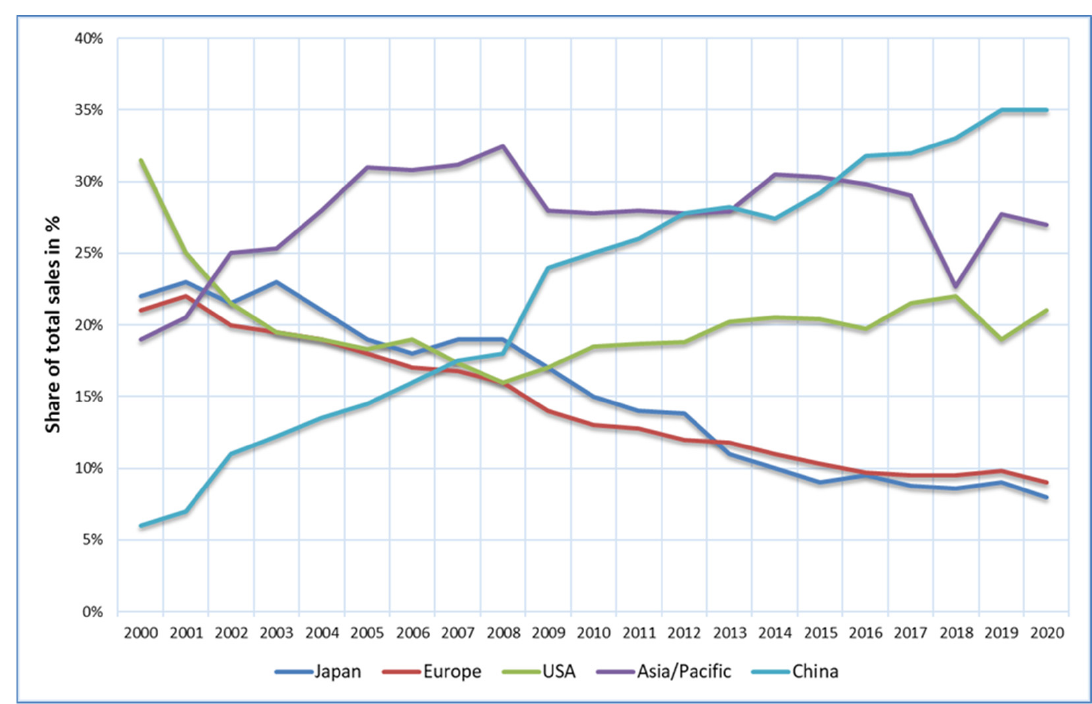
Figure 1. Development of market shares in semiconductor sales, 2000 – 2020 [3,4].